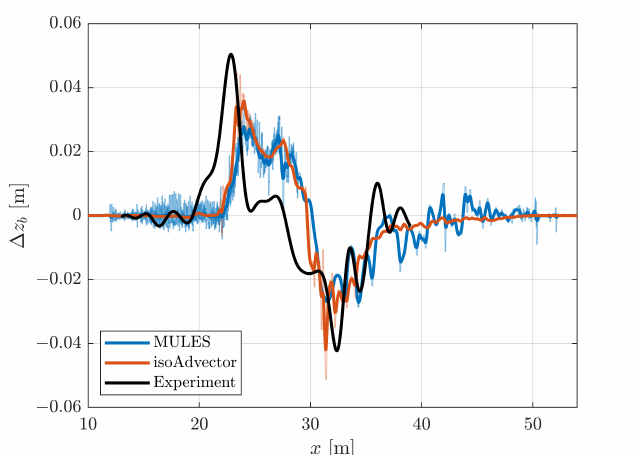
Figure 10. Comparison between morphology produced by models using MULES and isoAdvec- tor. In both cases, the Engelund and Fredsoe [37] model was used to calculate the reference con- centration. The thin lines show the original data and the thick lines show the same data after a smoothing